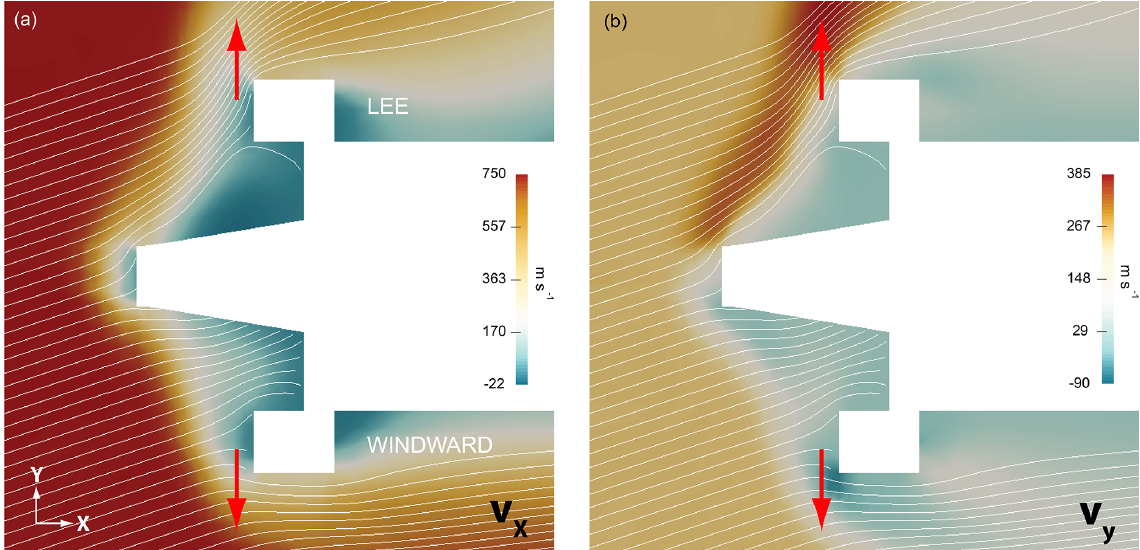
Figure 9. Numerical results of an aerodynamic simulation of the payload at a trajectory point at 85km of altitude during downleg. Colors indicate the components of the velocity vector. (a) Longitudinal ( x ), (b) lateral ( y ). Red arrows mark the sensor position and the orientation of the electrode